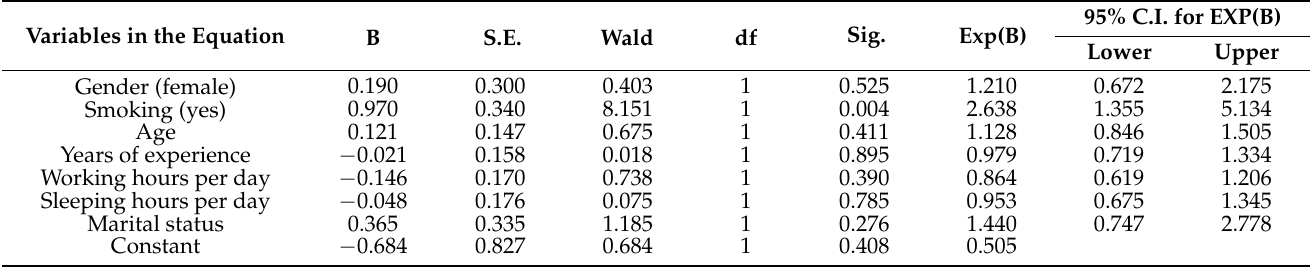
Table 4. Binomial regression results for lower back disorder with different study characteristics.